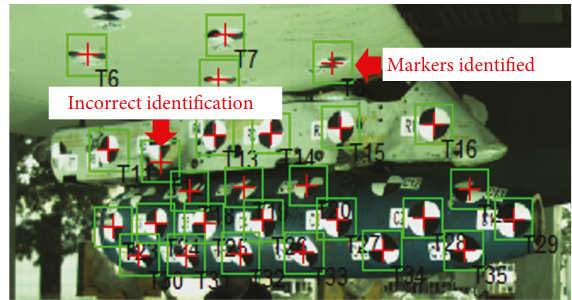
Figure 27: Image with identi fi ed markers and region of interest (green bound box) highlighted in each reference, used for the next frame in order to maintain tracking of markers.